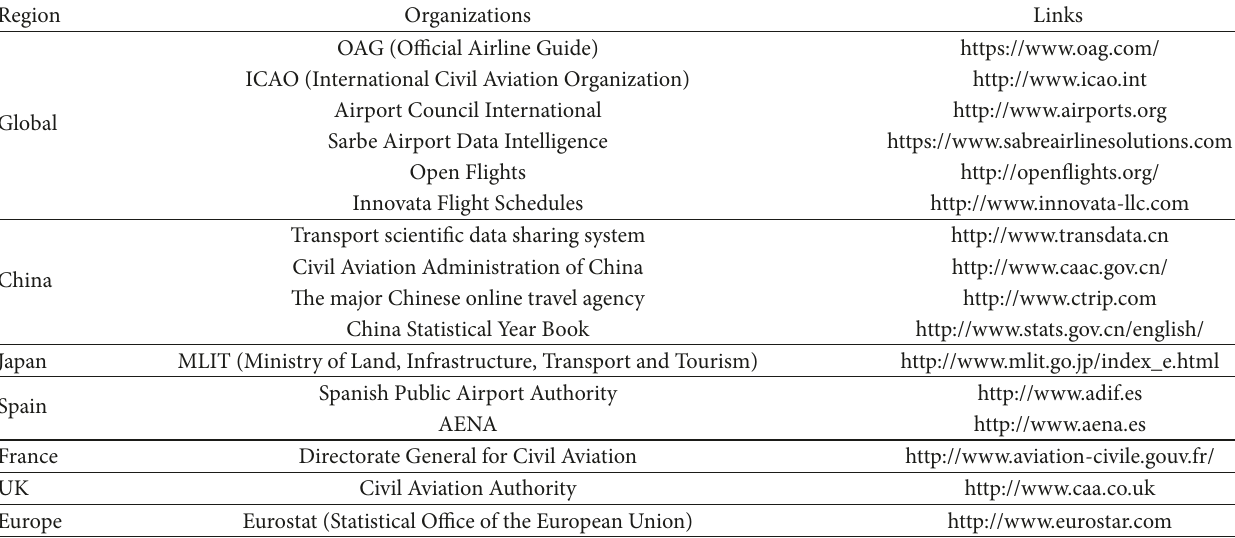
Table 3: An overview of the data sources for air transport.